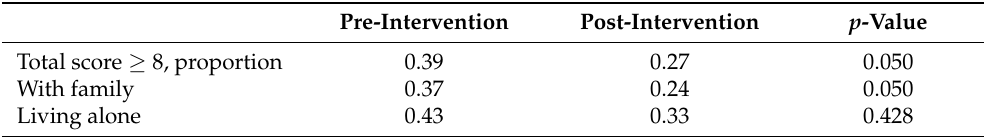
Table 3. Change in the number of participants with a Kihon Checklist score of 8 or